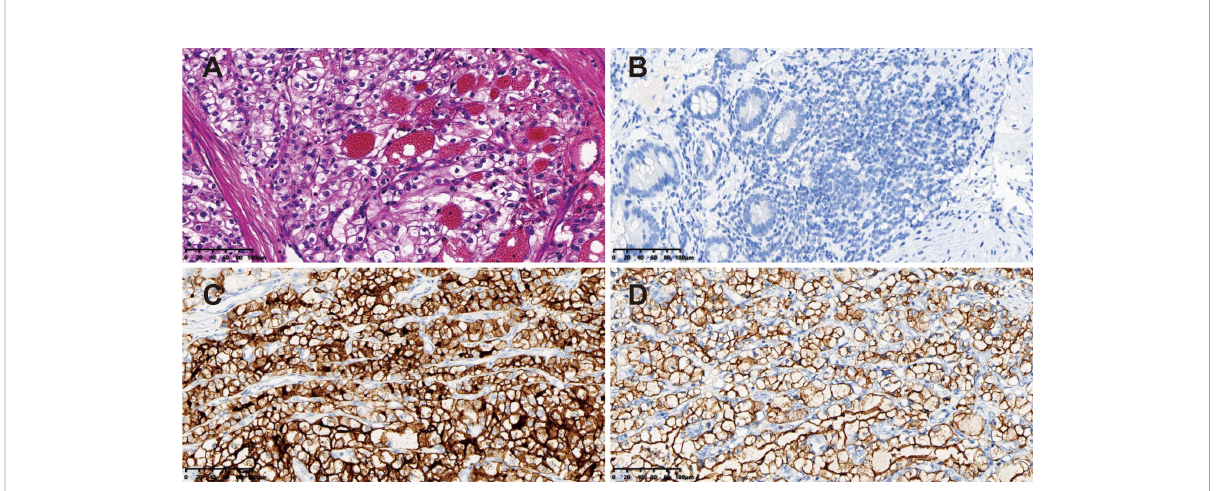
FIGURE 3 Pathological fi ndings of the surgical specimen. (A) Hematoxylin & eosin staining showing compact nests of tumor cells with clear cytoplasm separated by delicate vasculature (magni fi cation power: 20×). Immunohistochemical staining of the tumor revealing (B) PAX-8 (+), (C) CD10 (+), and (D) EMA (+) (magni fi cation power: